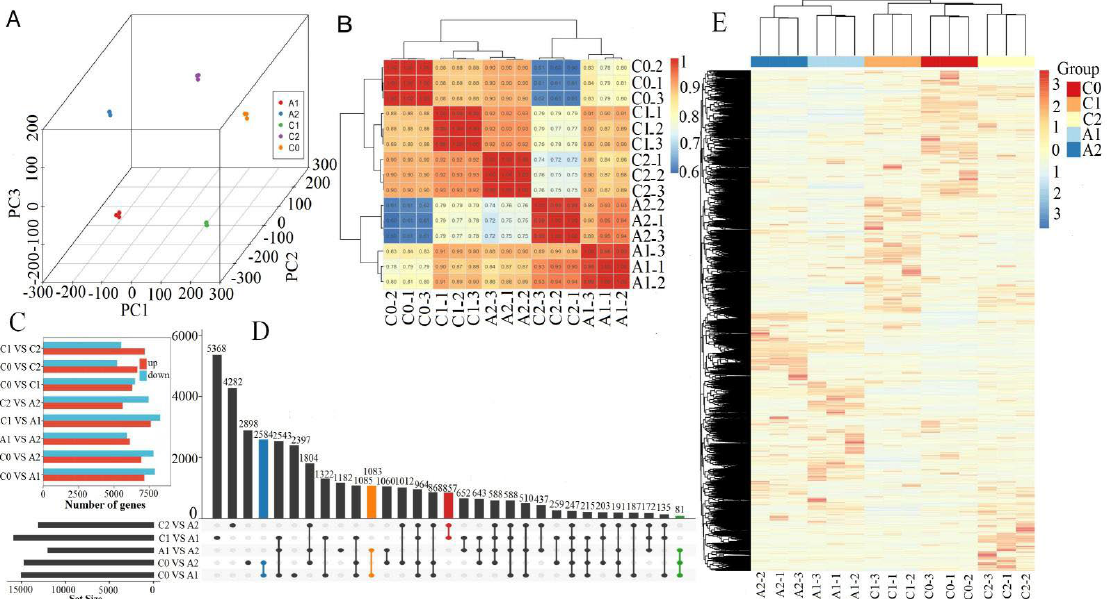
Figure 2. Global analysis of transcriptome data. ( A ) Principal Component Analysis (PCA) of the RNA-Seq data. ( B ) Sample correlation coefficient clustering heat–map. ( C ) Comparison of the differential expressed genes of each pair. The red or blue bar indicates the up- regulated or down−reg- ulated genes, respectively. ( D ) The Venn analysis for the number of DEGs between different-sample vs sample-groups. ( E ) Heat map indicating the different expression pattern of DEGs for classifica- tion.